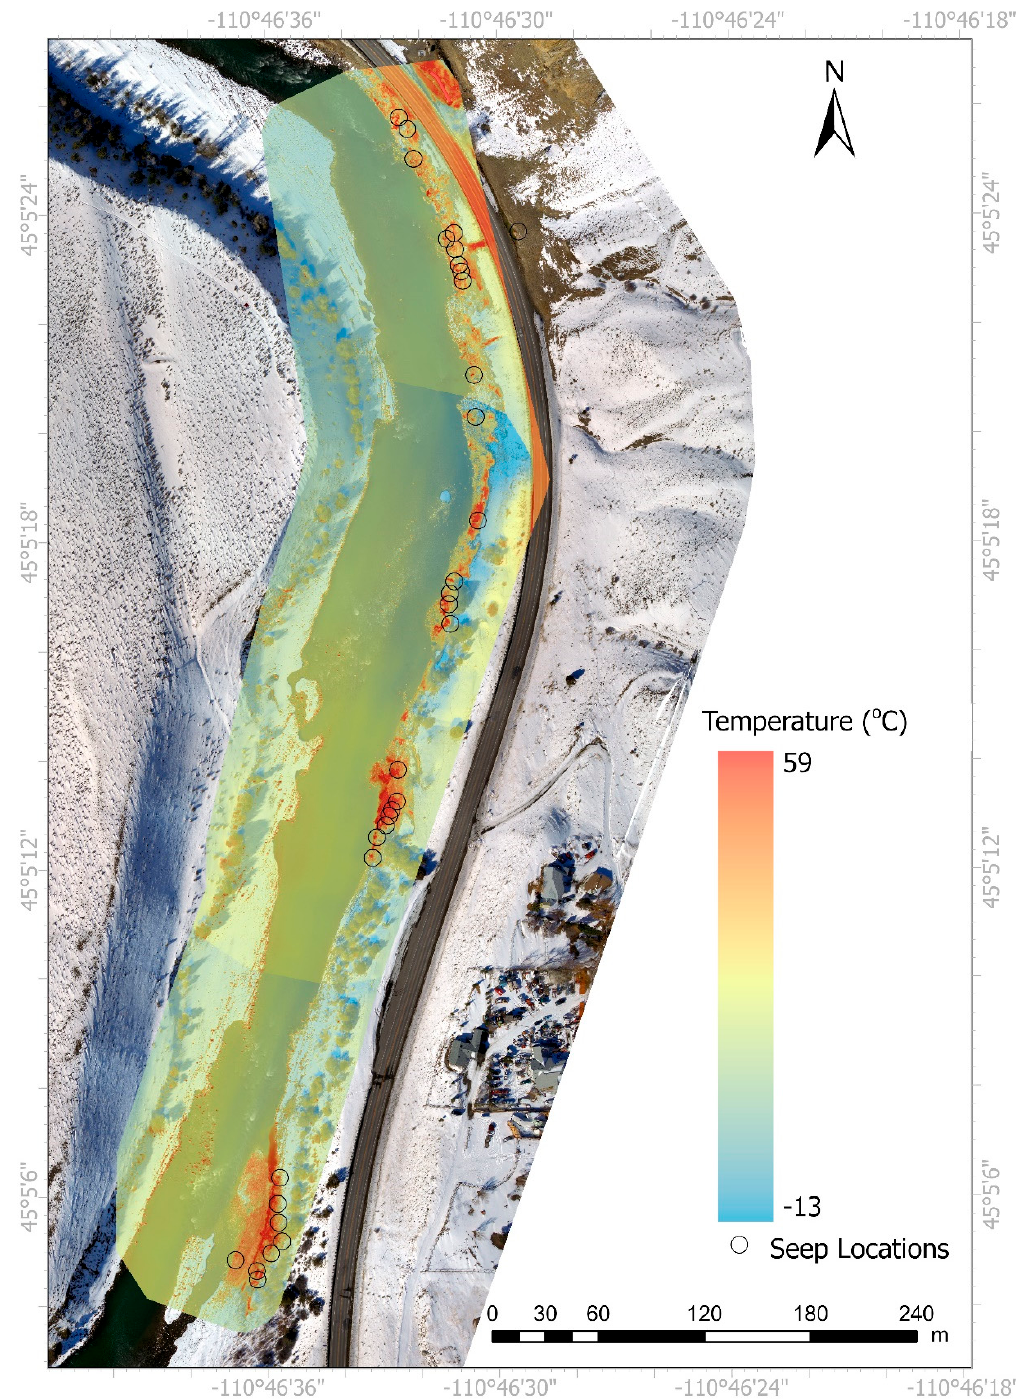
Figure 8. Thermal orthomosaics using transformed thermal data generated in Pix4D Mapper and Georeferenced in ArcPro for March. Seep locations that were surveyed in March 2019 were also included for reference. TIR orthomosaics correspond to the flight data from March 2019.